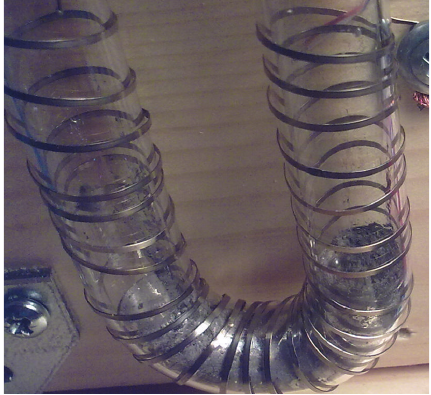
Figure 2: Carbon in the U